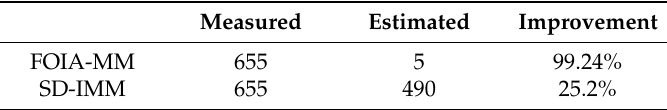
Table 6. Number of positions located in the obstacle